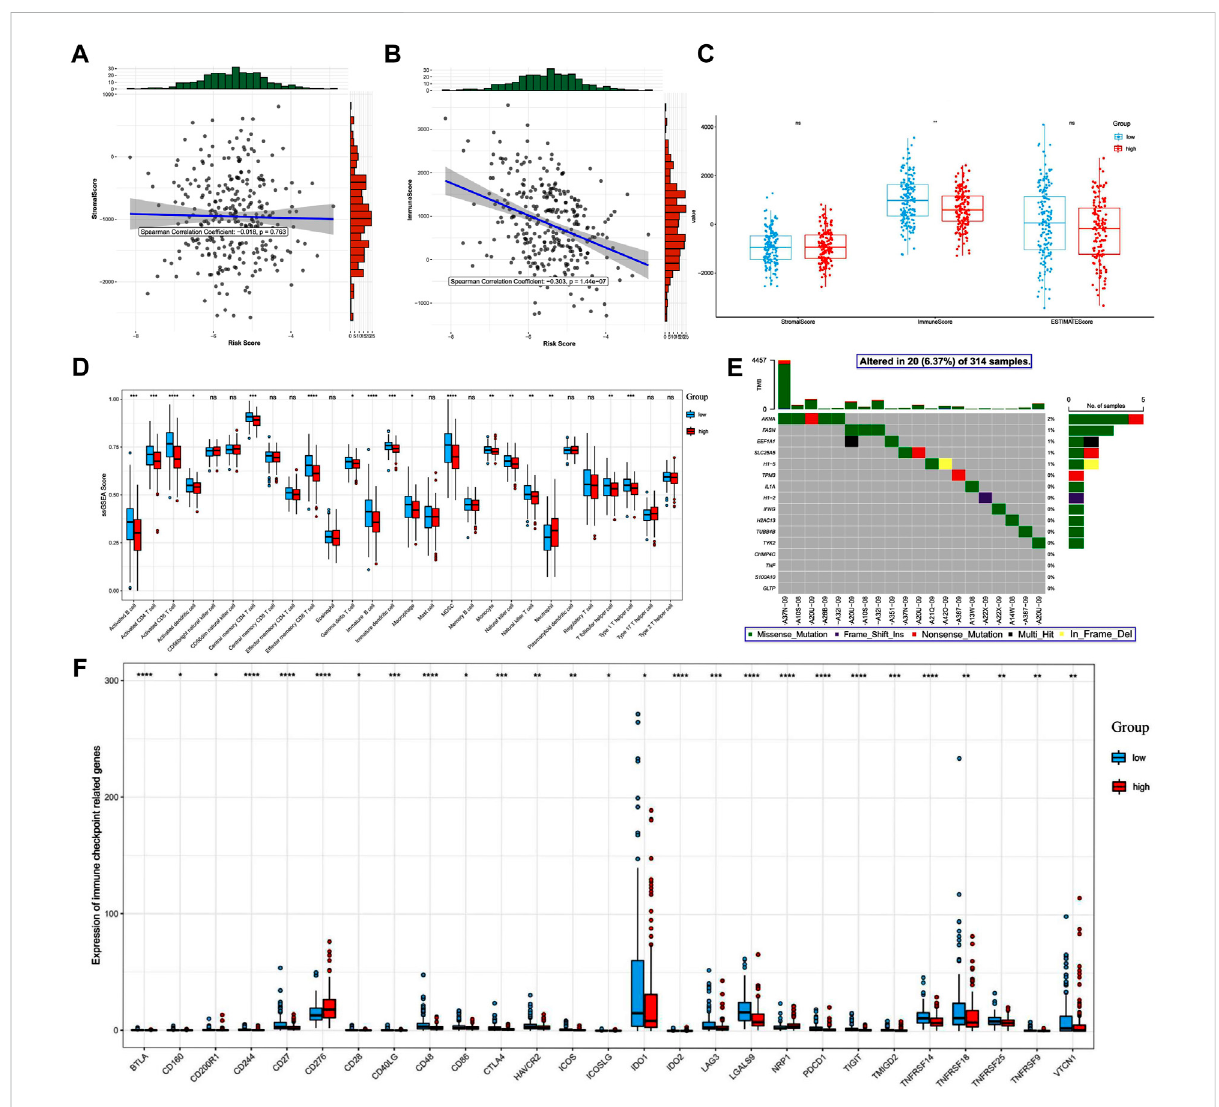
FIGURE 8 Differences in immune-related outcomes between the high-risk and low-risk groups. Risk and ESTIMATE scores: (A) correlation between the risk score and the stromal score. (B) Correlation between the risk score and the immune score. (C) Differences in tumor microenvironment scores between the high- and low-risk groups. (D) Boxplot of differences in the degree of immune cell in fi ltration. (E) Mutation map of prognosis-related genes in patients with cervical cancer. (F) Differential expression of immune checkpoint